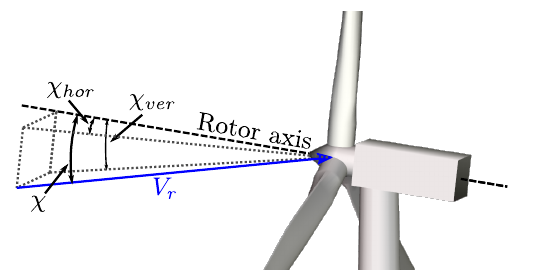
Figure 6. χ hor and χ ver are the angles between the inflow and the rotor axis in the horizontal and vertical planes